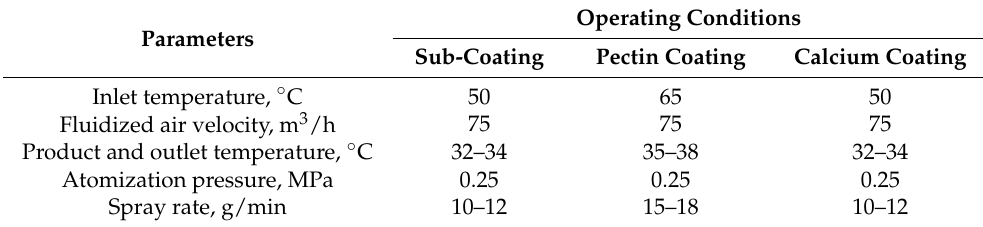
Table 2. Operating conditions for sub-coating, pectin coating, and calcium